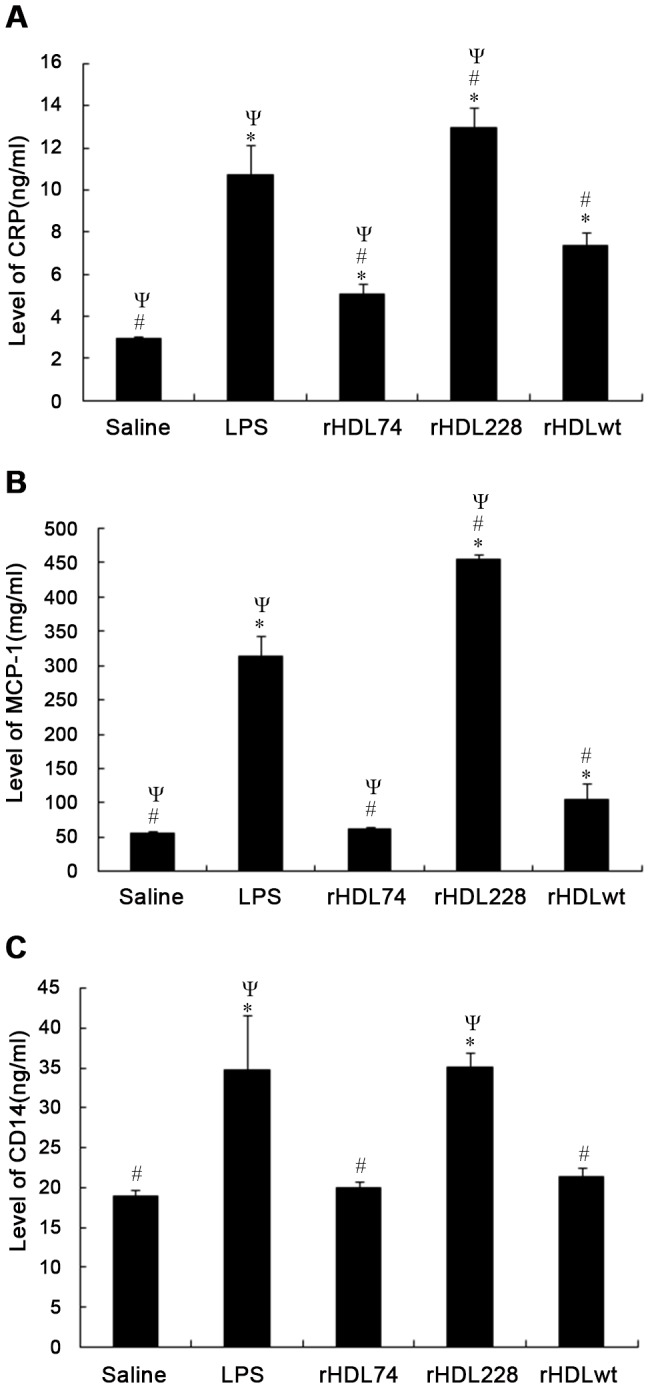
CRP, MCP-1 and CD14 levels at 24 h after LPS injection.Control: without any treatment. LPS, rHDLwt, rHDL74 and rHDL228 represent the groups that were treated with LPS, LPS+rHDLwt, LPS+rHDL74 and LPS+rHDL228, respectively. Compared with the LPS group, mice treated with rHDL74 showed significantly decreased levels of CRP, MCP-1 and CD14. However, mice receiving rHDL228 exhibited higher levels of these factors. In addition, compared with rHDLwt, rHDL74 significantly reduced the level of CRP and MCP-1. To confirm our experimental results, we performed three independent experiments. A: Levels of CRP. B: Levels of MCP-1. C: Levels of CD14. *P<0.05 vs. control; #P<0.05 vs. LPS; ΨP<0.05 vs. rHDLwt. Error bars indicate the SD.